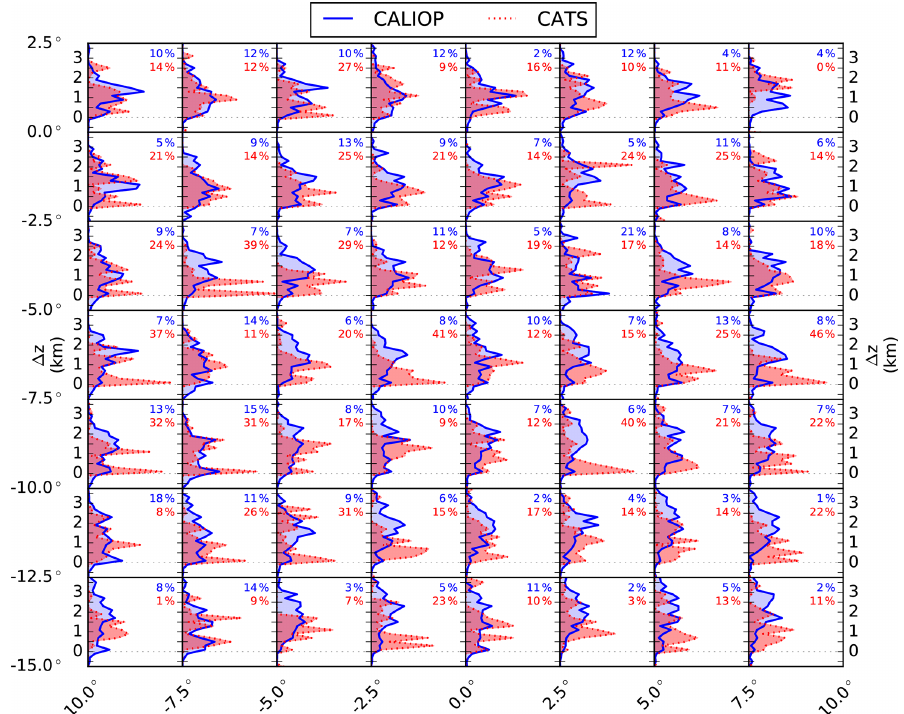
Figure 1. Normalized frequency of occurrence of the gap distance between cloud layer top and aerosol base heights from CALIOP (blue solid line) and CATS (red dotted line) for single layer coincidences of aerosol and cloud in the months of July, August, and September (2007–2016 for CALIOP; 2015–2017 for CATS) over the southeast Atlantic (15 ◦ S to 2.5 ◦ N, 10 ◦ W to 10 ◦ E). Layer heights are binned from − 1 . 5 to 5.5km in 200m increments, and data in each grid have been normalized to the maximum frequency across the whole study area. The percentage of scenes in which the aerosol layer base is less than 360m above the cloud-top height is shown in the top right of each subplot for each